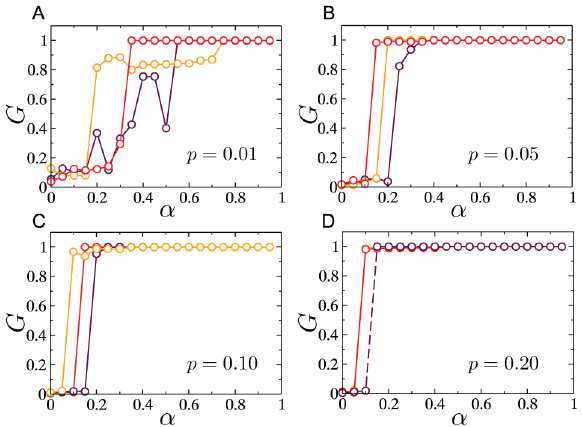
Figure 6. Effect of rewiring on cascades in RGGs. Cascades were triggered by the removal of the highest load. Simulations were performed on networks of size N ~ 1300 with S k T ~ 5 : 0 . As p is increased the lack of self-averaging that manifests itself in the form of non-monotonicities in the curves for G versus a , disappears.